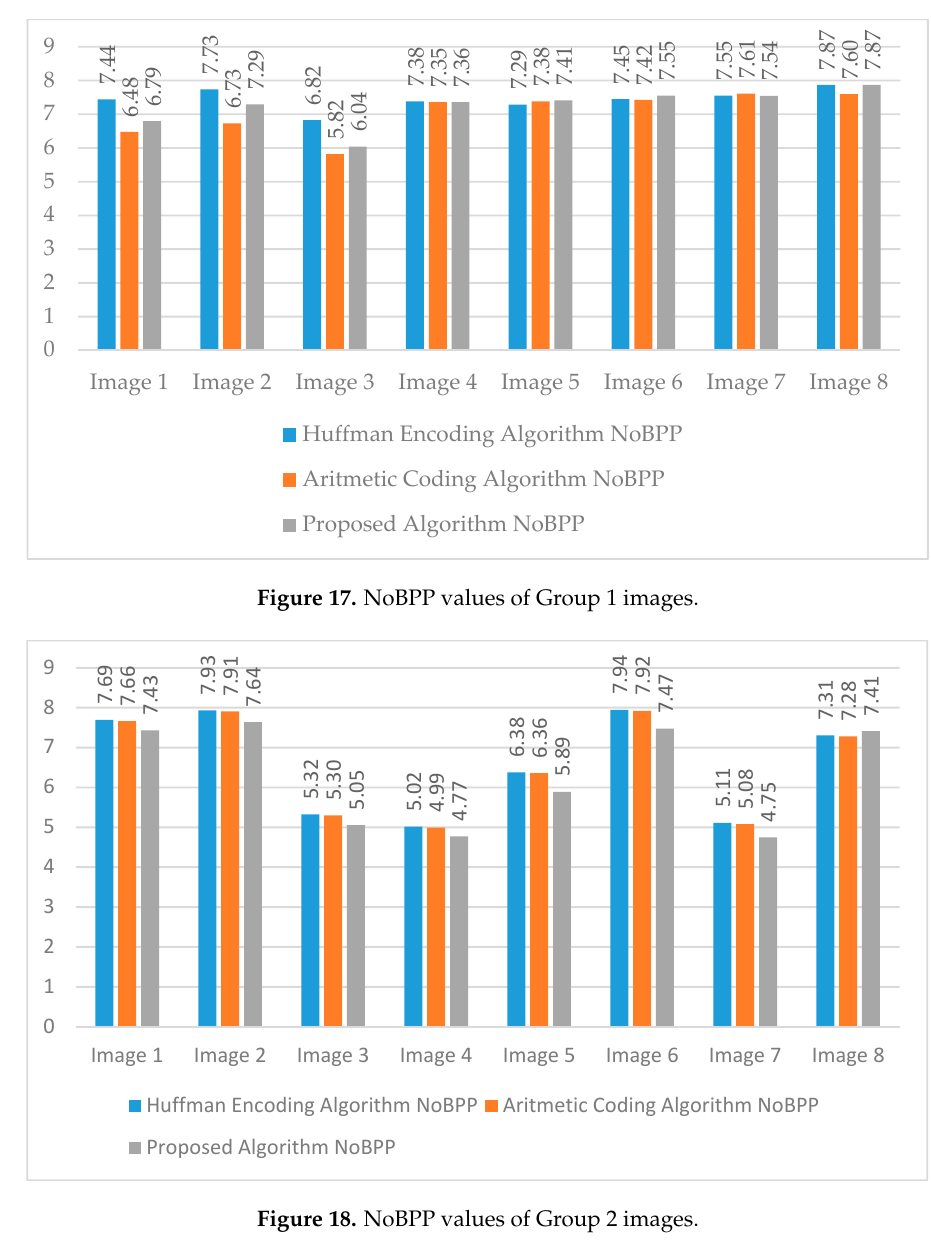
Figure 16. CP values of Group 3 images.